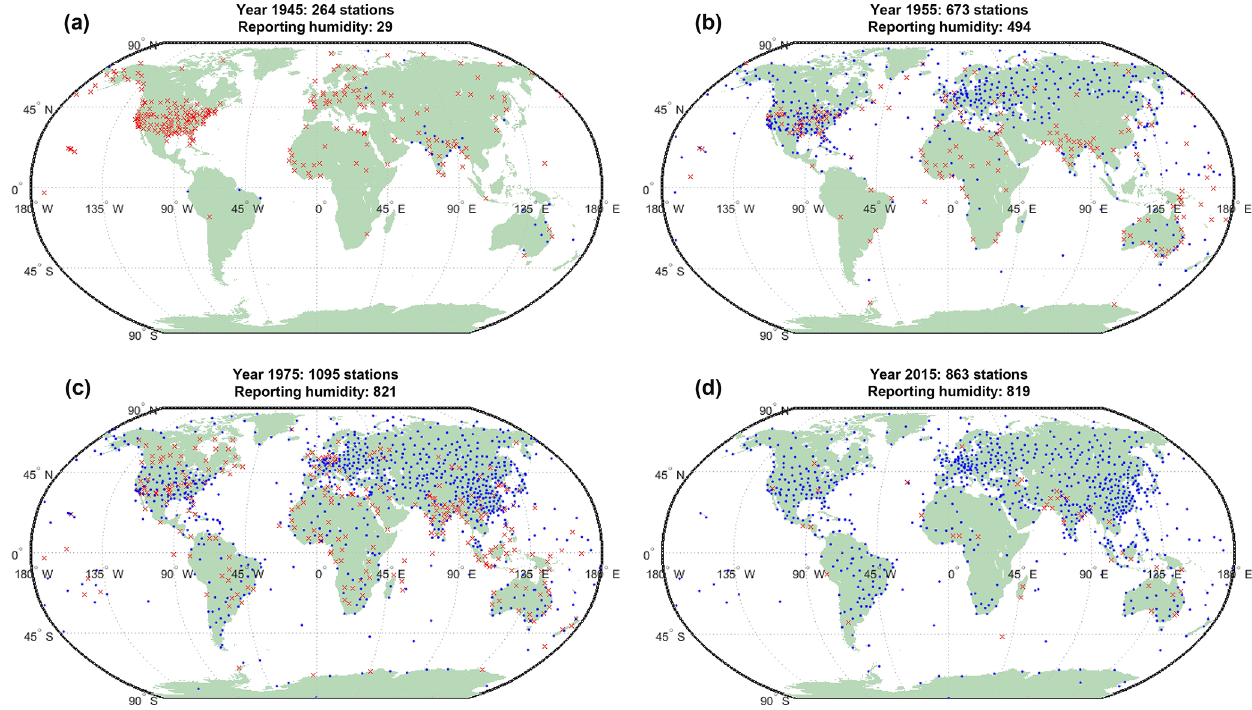
Figure 3. Locations of IGRA-RS fixed stations active in the years of (a) 1945, (b) 1955, (c) 1975, and (d) 2015. Note the interval of time doubles between consecutive panels. Blue dots denote the stations reporting humidity (RH/DPD + temperature) anytime in the year; red crosses denote stations reporting only temperature/wind, or else presenting a data record gap, during the same year. The total number of stations (crosses + dots) refers to the active stations in each year regardless of any data record gaps.